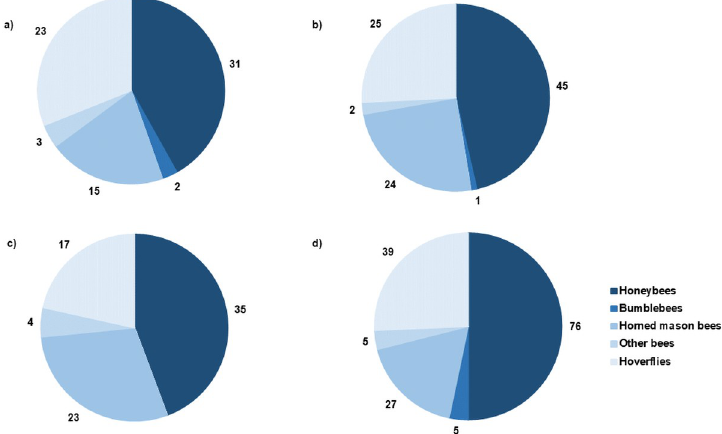
Fig 1. Distribution and total number of insects monitored during transect walks at five time points following microbial inoculation of flowers (data from 2019 and 2020 combined). Treatments included inoculation of flowers with the yeast Metschnikowia reukaufii (b), the bacterium Acinetobacter nectaris (c), and a combination of both (yeast + bacteria (d)). As a control, flowers were sprayed with water (a).